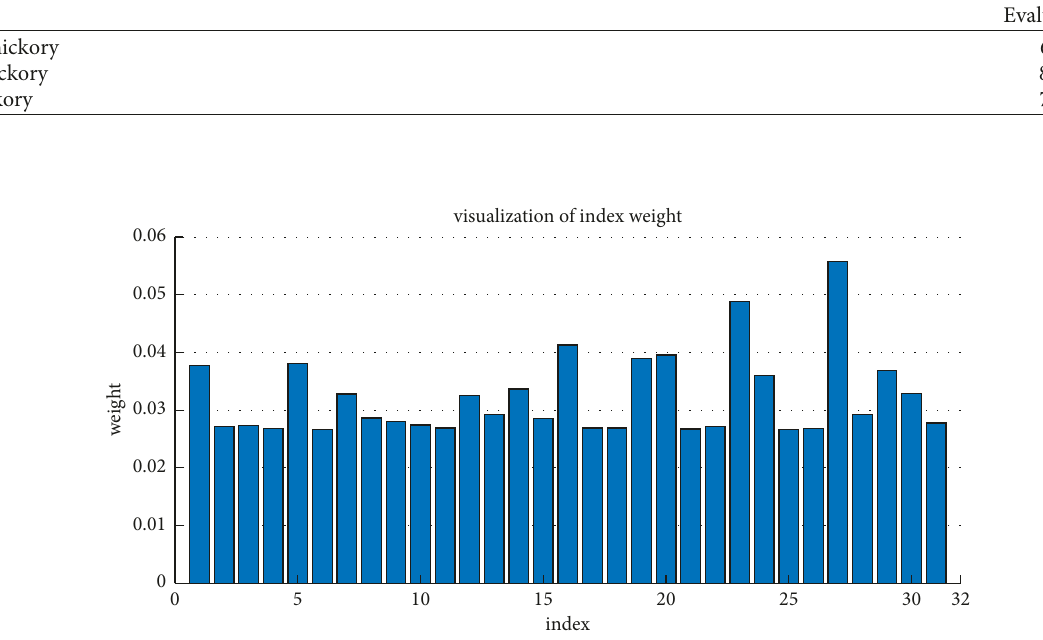
Figure 2: The weights of 31 indexes of three kinds of hickories with nutrient and texture. Table 5: Scores of three kinds of hickories considering nutrition, texture, and